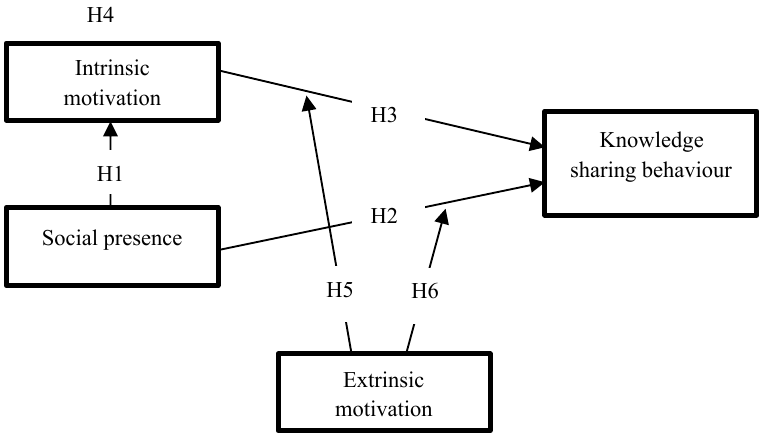
Figure 1: Research Framework